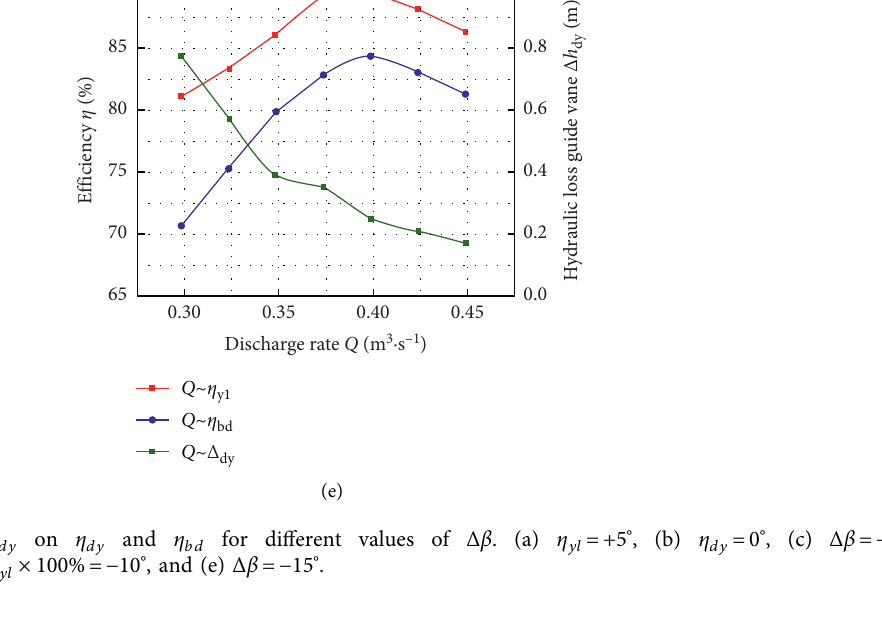
dy on η dy and η bd for different values of Δ β . (a) η yl